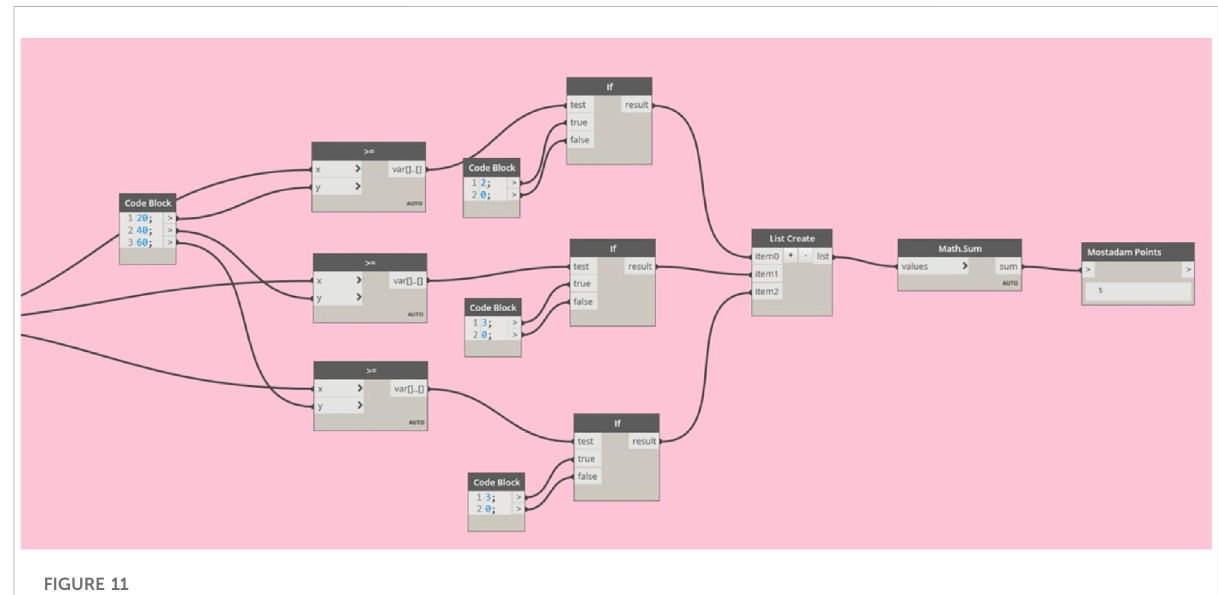
FIGURE 11 Part of dynamo script showing the computation of Mostadam point earned.